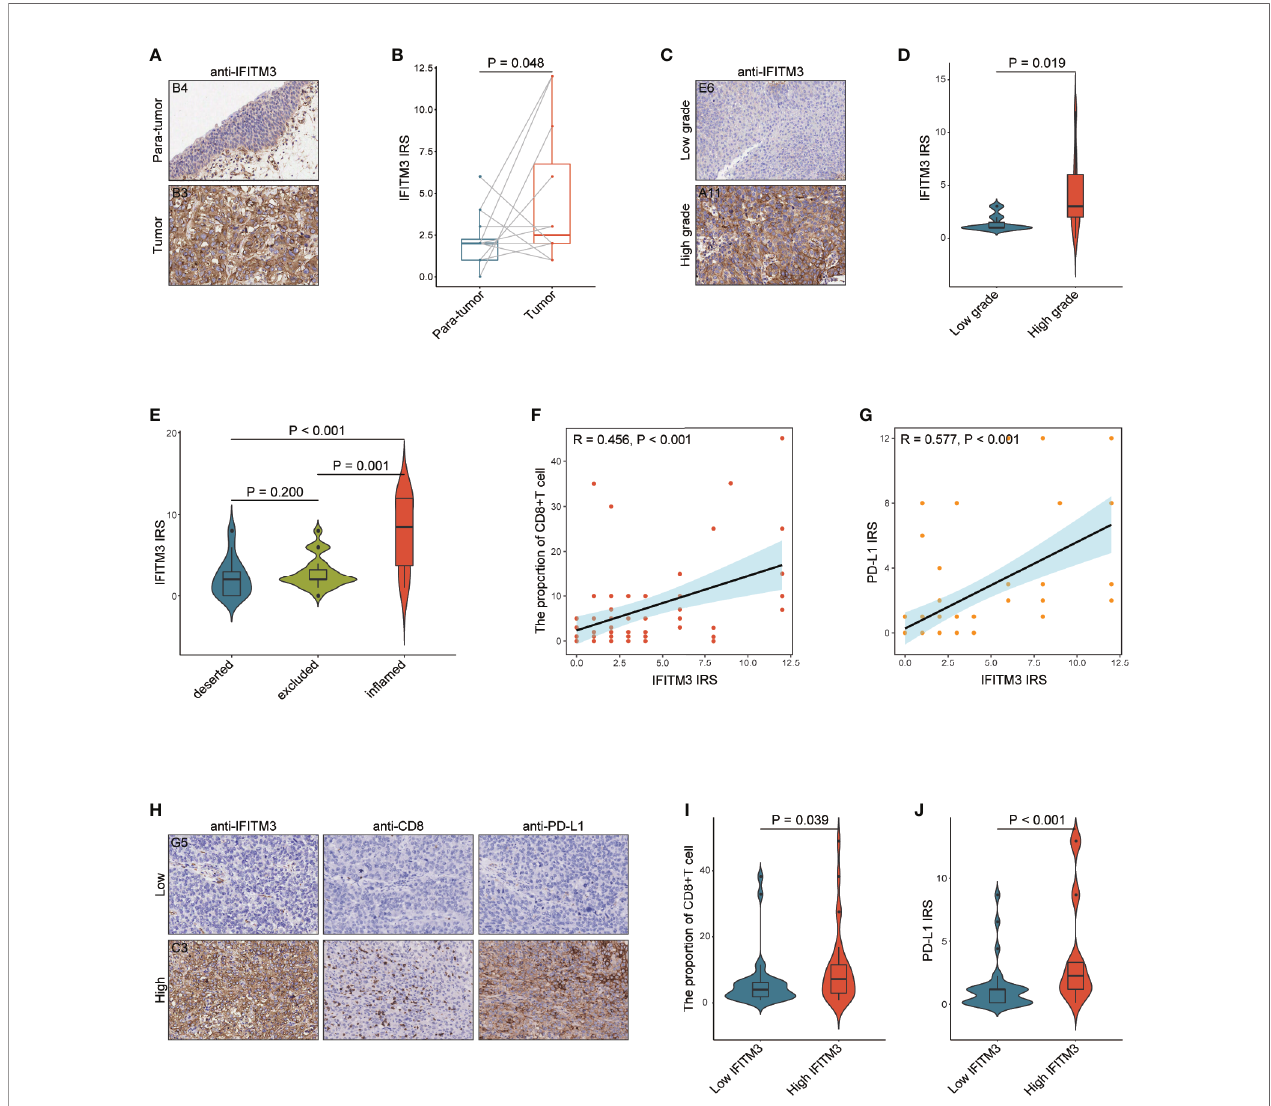
FIGURE 6 | The role of IFITM3 in predicting clinical and immune phenotypes in the recruited TMA cohort. (A) Representative images revealing IFITM3 expression in tumor and paratumor tissues using anti-IFITM3 staining. Magni fi cation, 200×. (B) Expression levels of IFITM3 in tumor and paratumor tissues. (C) Representative images revealing IFITM3 expression in high- and low-grade tumor tissues using anti-IFITM3 staining. Magni fi cation, 200×. (D) Expression levels of IFITM3 in high- and low-grade tumor tissues. (E) Expression level of IFITM3 in the deserted, excluded, and in fl amed phenotypes. (F) Correlation between IFITM3 expression and CD8+ T-cell in fi ltration levels. (G) Correlation between IFITM3 and PD-L1 expression. (H) Representative images revealing CD8+ T-cell in fi ltration and PD-L1 expression in the high- and low-IFITM3 groups. Magni fi cation, 200×; (I) CD8+ T-cell in fi ltration level in the high- and low-IFITM3 groups. (J) Expression level of PD-L1 in the high- and low-IFITM3